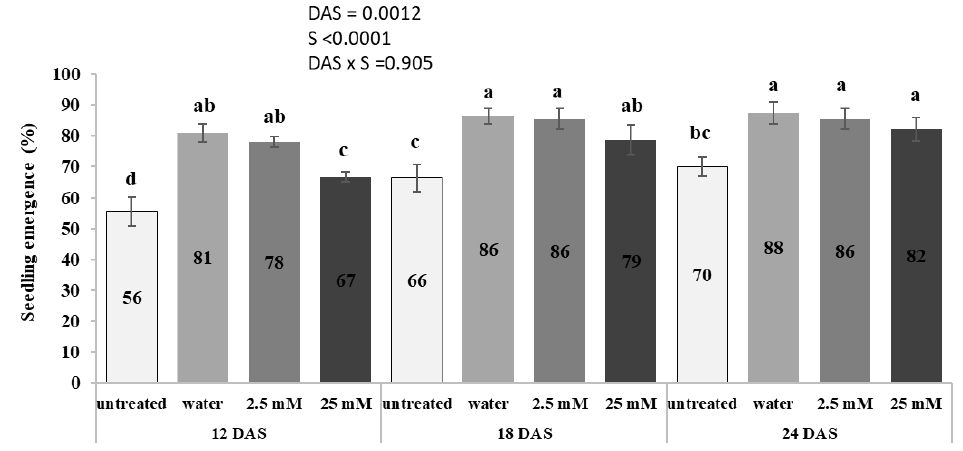
Figure 4. Percentage of seedlings with visible coleoptiles at 12, 18 and 24 days after sowing (DAS). Values are means ± standard errors ( n = 80). Different letters demonstrate significant differences ( p < 0.05).